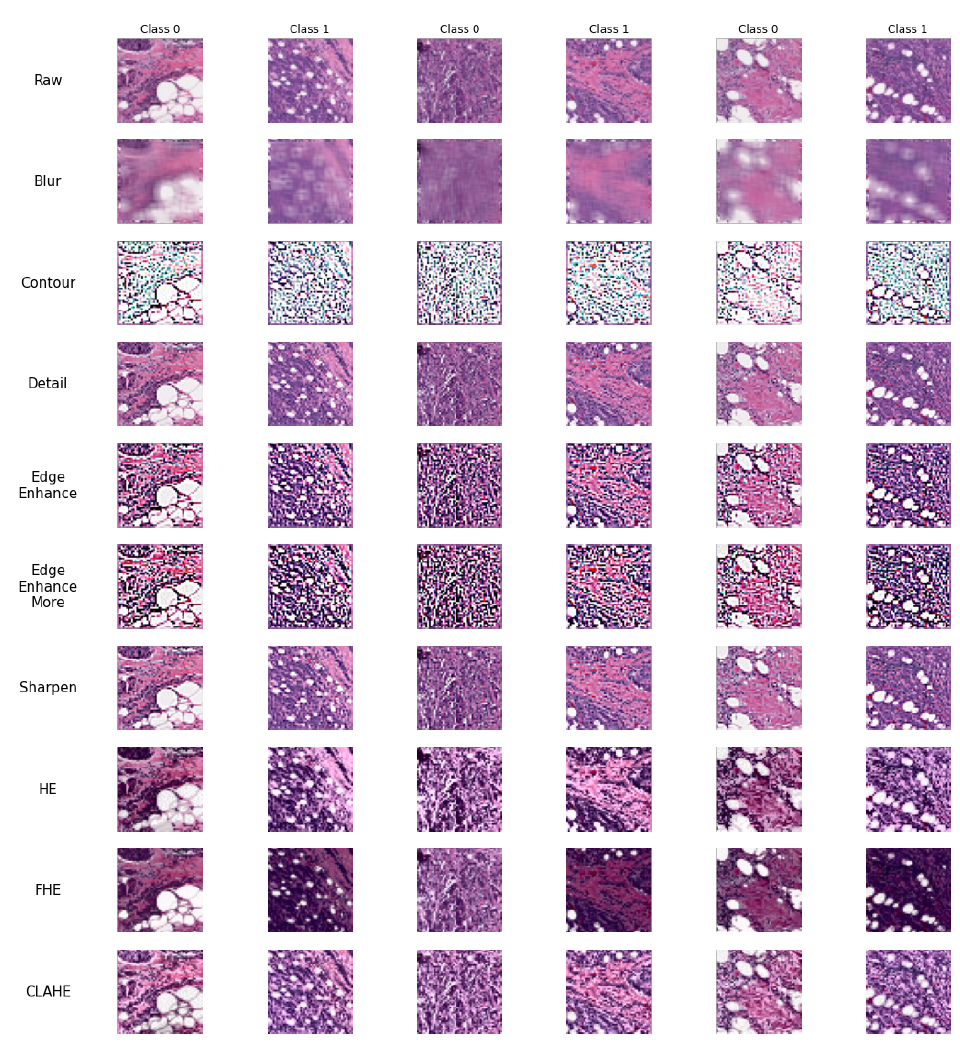
Figure 2. Some examples of how filters act on different